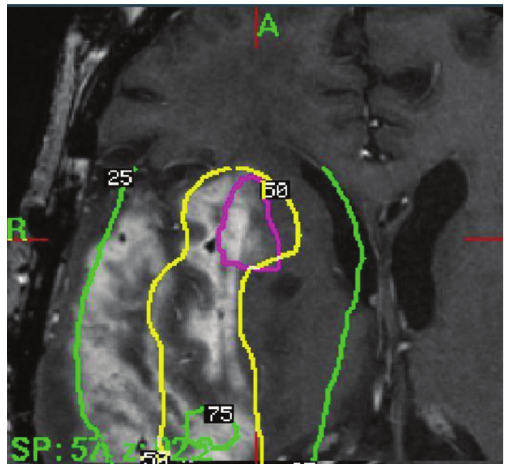
Figure 1: Gamma Knife treatment planning illustration of dose on an axial T1 postgadolinium MRI scan for the first Gamma Knife